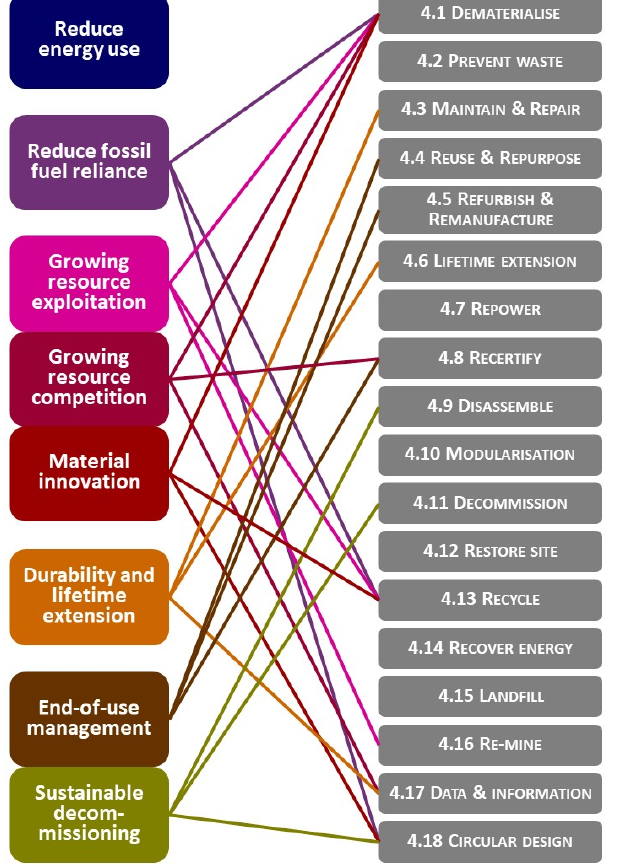
Figure 4. Top three circular economy strategies (on the right, as introduced in Section 4) in response to circular economy-related sustainability challenges and opportunities (on the left, as introduced in Section 2.2).